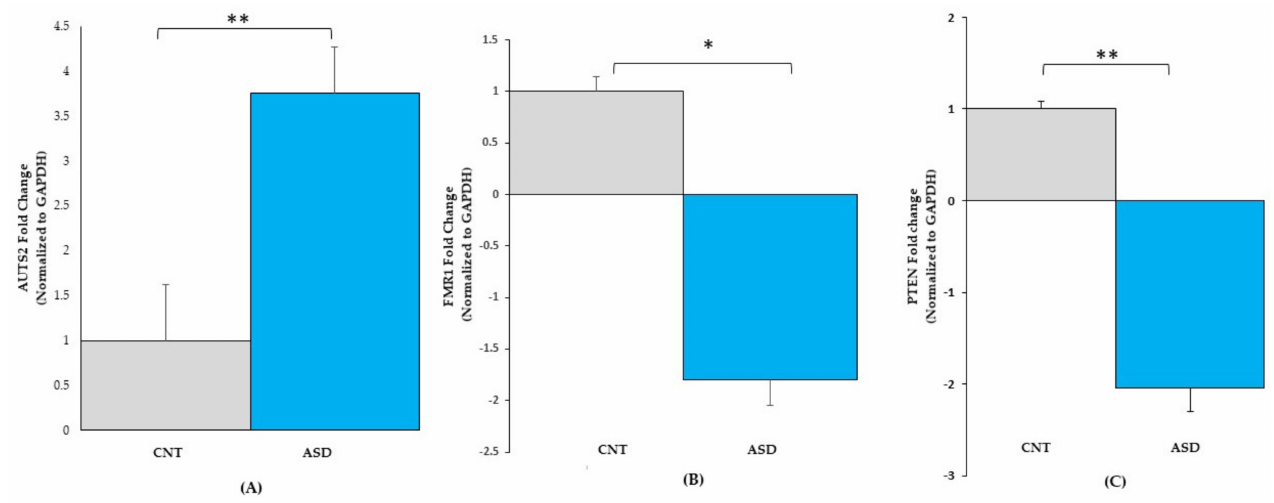
Figure 4. qRT-PCR validation of gene expression in LCL groups for ( A ) AUTS2: CNT ( n = 4), ASD ( n = 4), ( B ) FMR1: CNT ( n = 7), ASD ( n = 10) and ( C ) PTEN: CNT ( n = 7), ASD ( n = 10). ASD = Autism, CNT = Control, * = p < 0.05, ** = p < 0.0001; error bars represent standard error of the